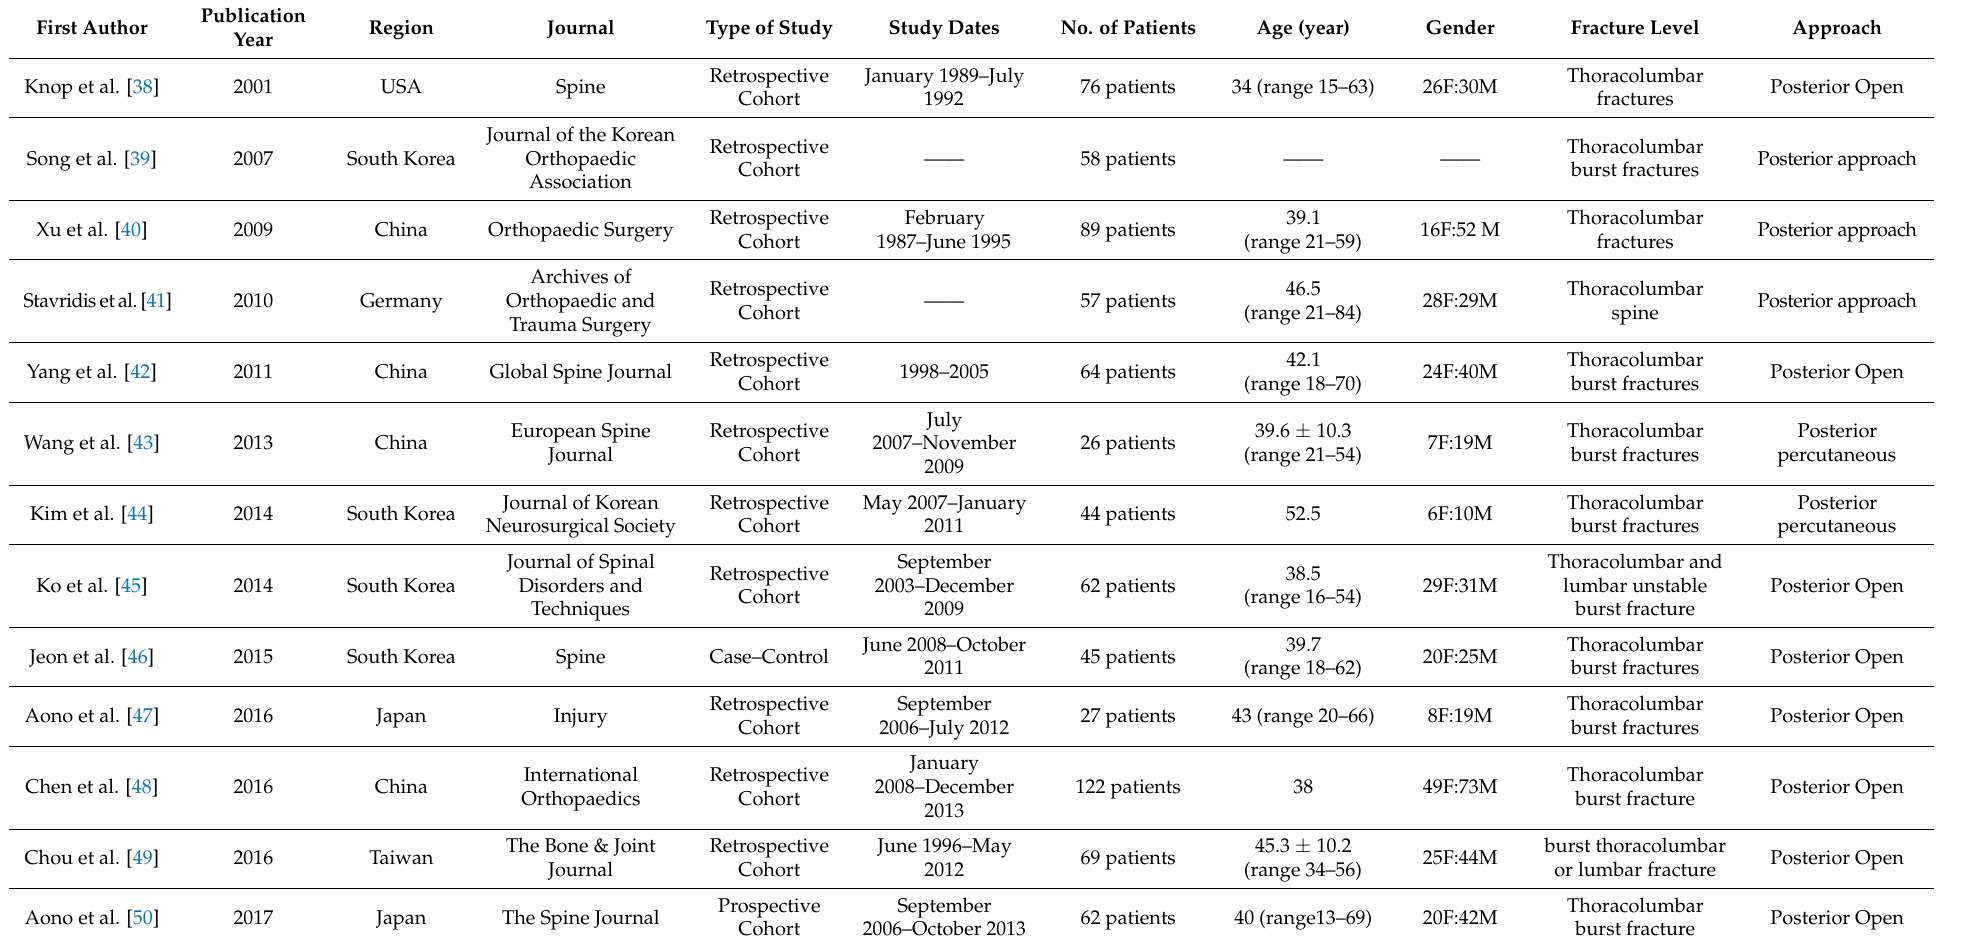
Table 1. Baseline characteristics of the included observational